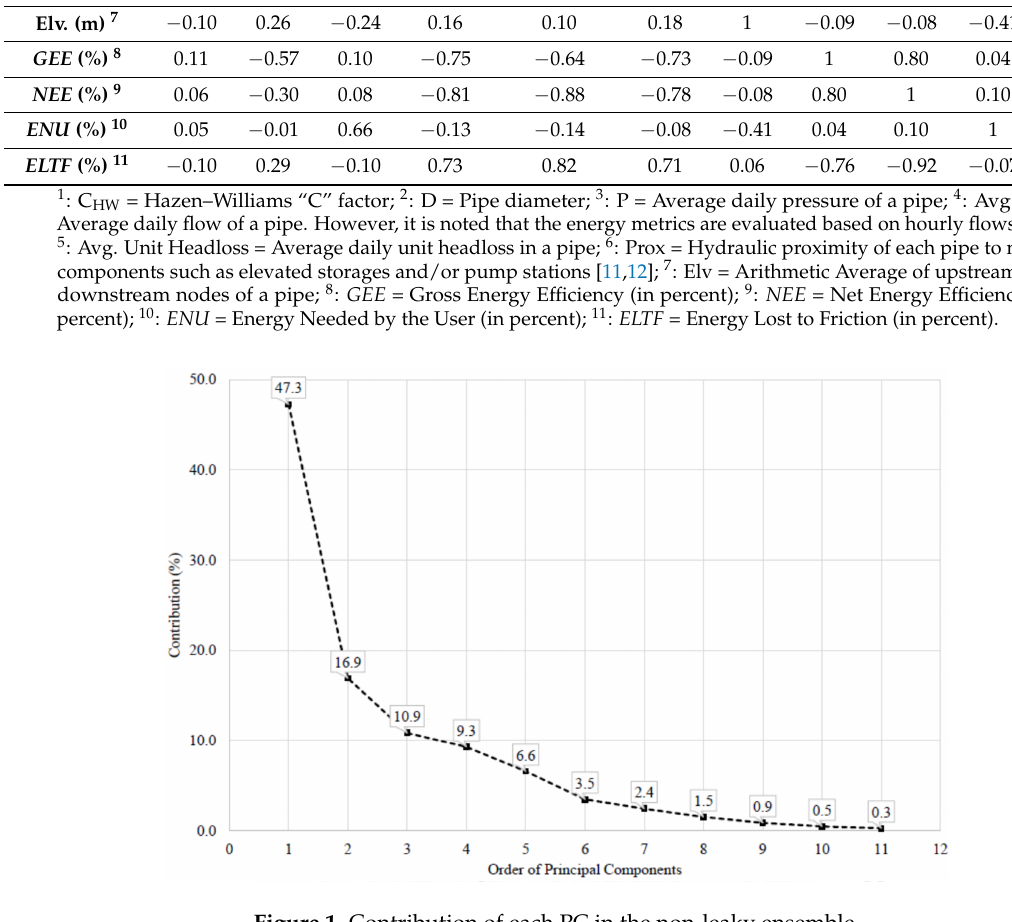
Figure 1. Contribution of each PC in the non-leaky